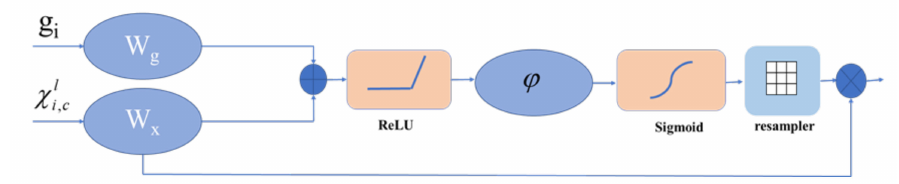
Figure 4. Schematic diagram of AG module